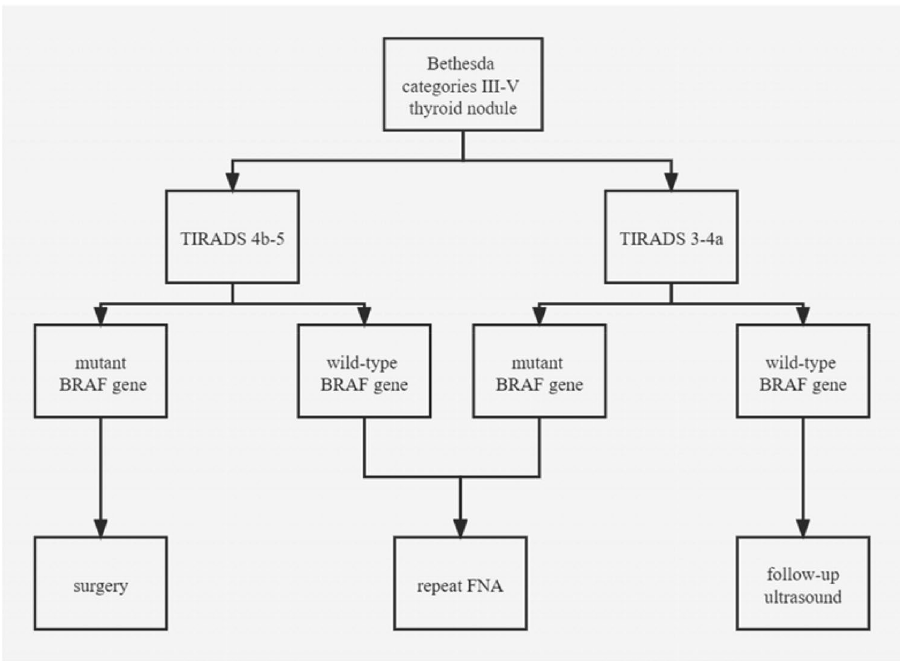
Figure 5. Managements of Bethesda categories III–V thyroid